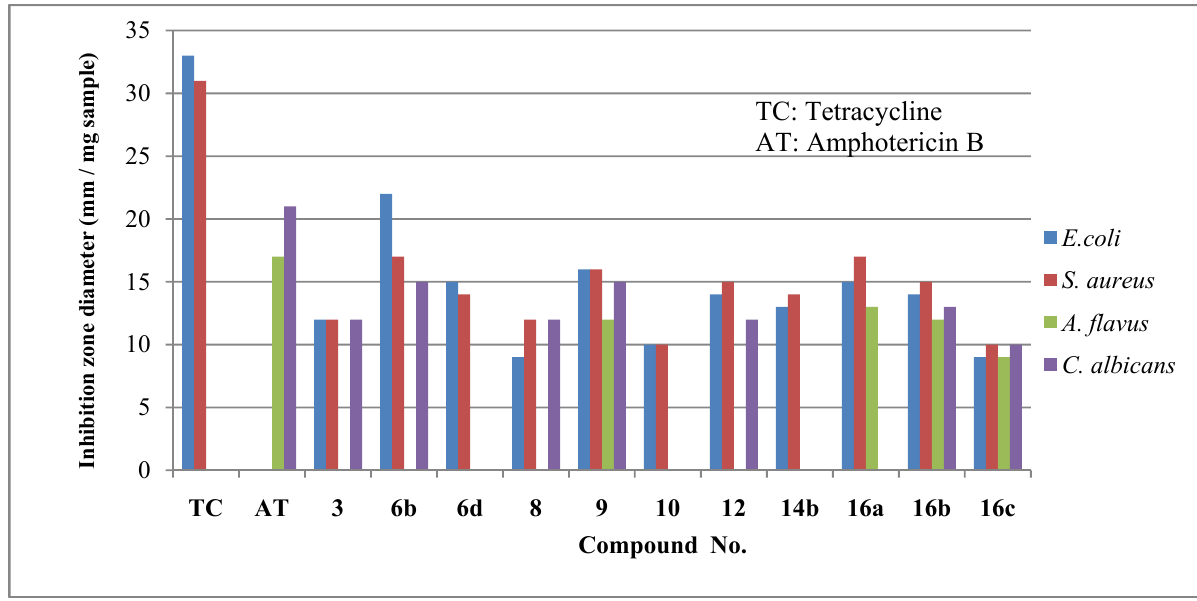
Figure 1. Graphical representation of the antimicrobial activity of tested compounds compared to tetracycline and amphotericin